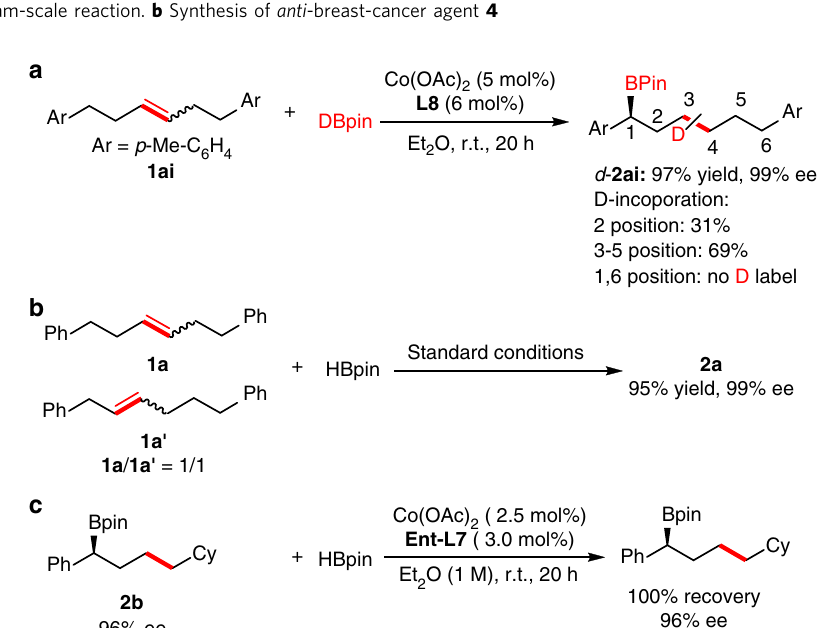
Fig. 4 Isotope labeling and control experiments. a Deuterium labeling experiment. b Utilization of a mixture of geometrical and positional alkene isomers. c The reaction of product 2b with HBpin using enantiomer of L7